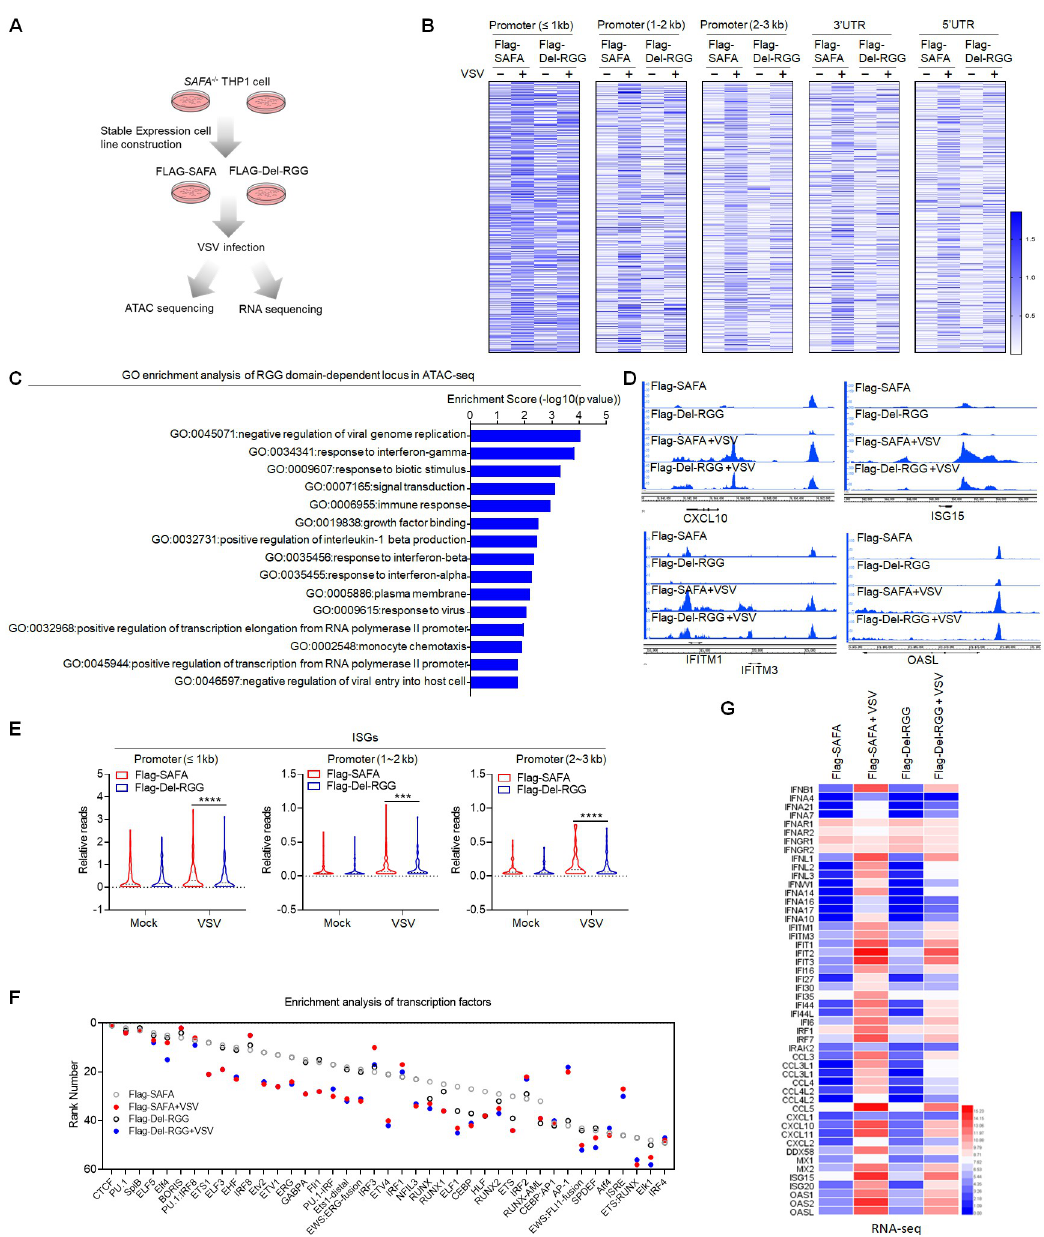
Fig 3. RNA binding activity of SAFA is critical for increasing the accessibility of anti-viral chromatin. (A) Models depicting the ATAC-seq and RNA-seq assay in Flag-SAFA and Flag-Del-RGG stably expressed SAFA − / − THP-1 cells with VSV infection for 6 hours. (B) Heatmap (log RPKM+1) showing the ATAC-seq signal. (C) GO term enrichment analysis of genes significantly affected by RGG domain depletion in ATAC-seq. (D) Genome browser views of ATAC-seq signal for the indicated genes. (E) Violin graph (log RPKM) showing ISGs affected by RGG domain depletion in ATAC-seq. (F) Transcription factor enrichment analysis of ATAC-seq. (G) Heatmap (log FPKM+1) showing RNA-seq signal for the indicated genes. ��� p < 0.001, ���� p < 0.0001 (Student’s t test; E). The cells were infected by VSV at 0.1 MOI. Data were pooled from two independent experiments (B, C and E-G). Data were representative of two independent experiments (D).